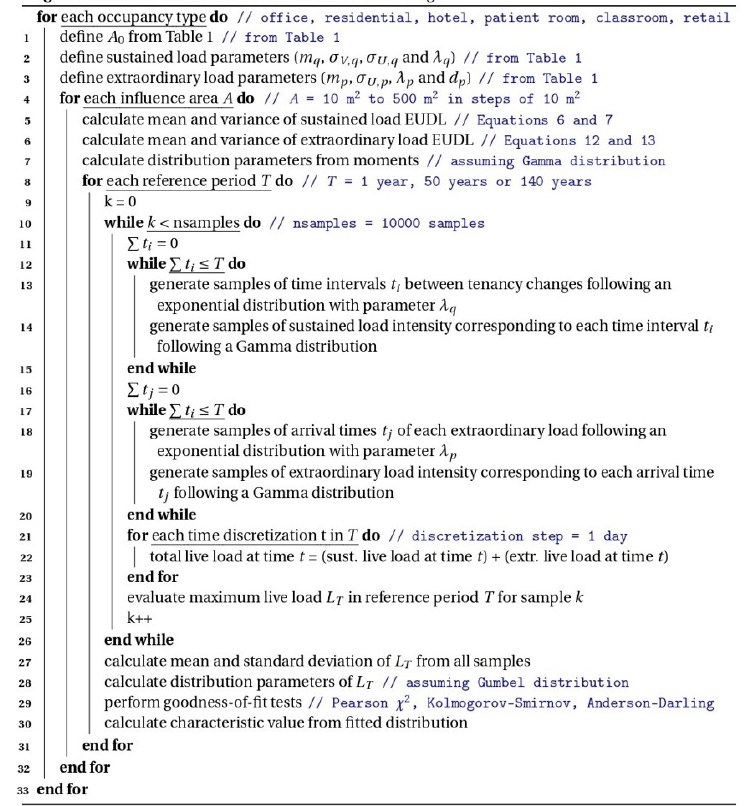
Figure 4. Pseudocode of Monte Carlo simulations of live loads in